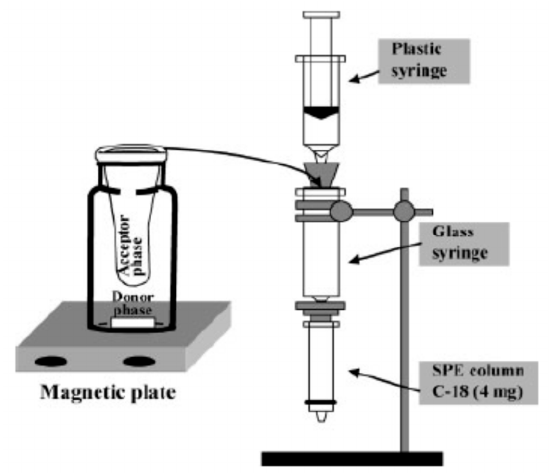
Figure 2. Equipment of SLM device set-up by Almeda et al. to extract and preconcentrate ochratoxin A (OTA) from wine samples. (Reproduced with permission from Almeda, Electrophoresis ; published by Wiley-WCH, 2008 [56]).